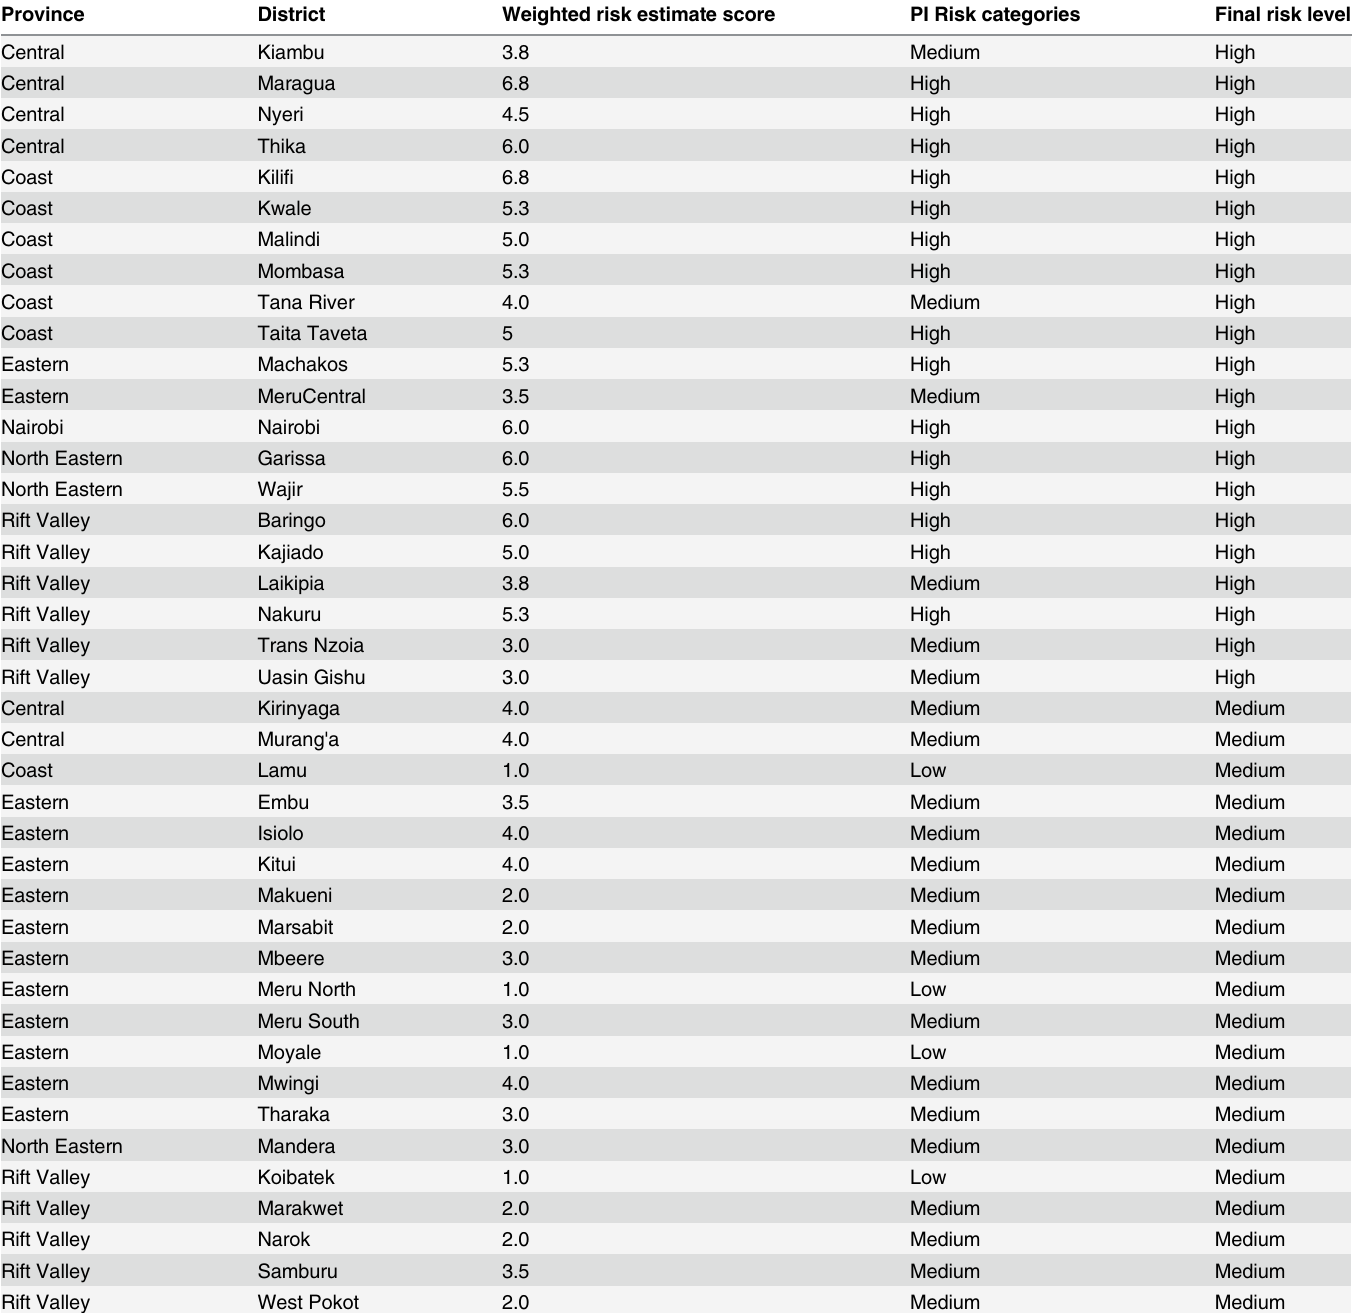
Table 2. List of RVF high and medium risk high districts as assessed by probability-impact scores and the final risk level after input from the ani- mal and experts.